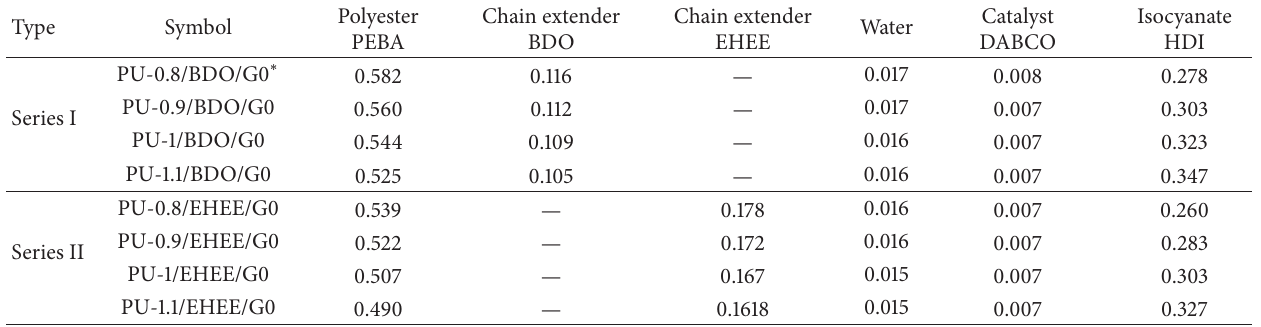
Table 1: The symbols and the molar ratio of substrates used in the synthesis of unmodified PU foams.